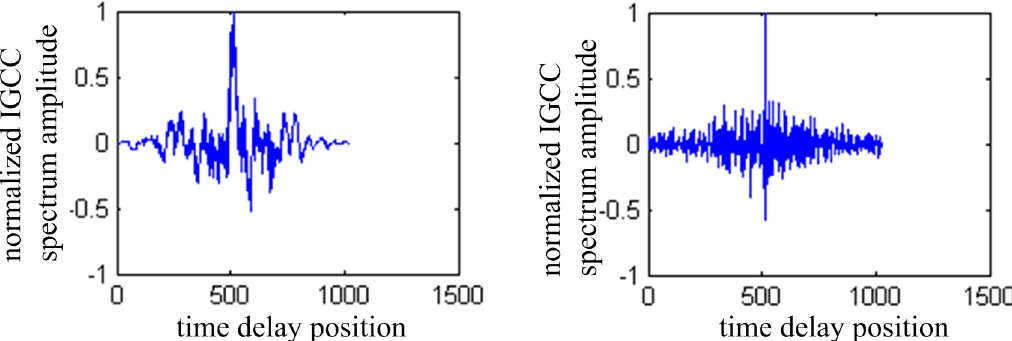
Figure 8. TDOA result of traditional GCC and IGCC.